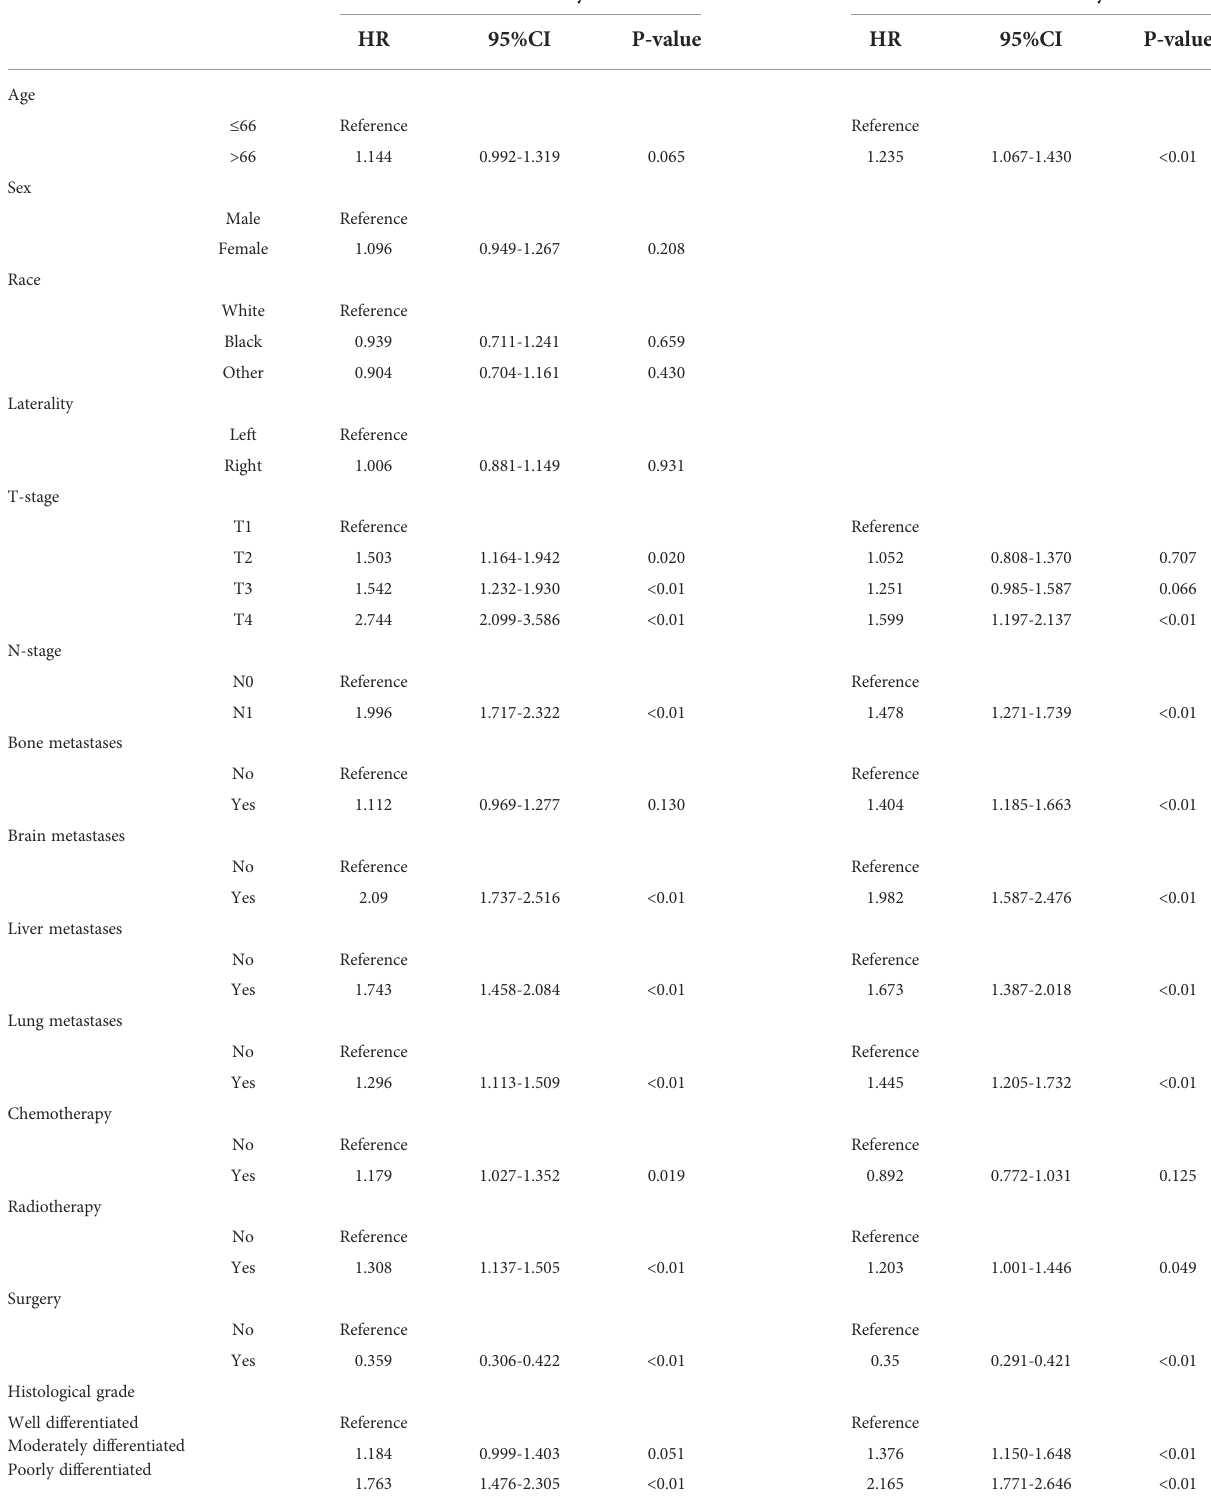
TABLE 2 Univariate and multivariate Cox regression analysis of included variables for CSS in training